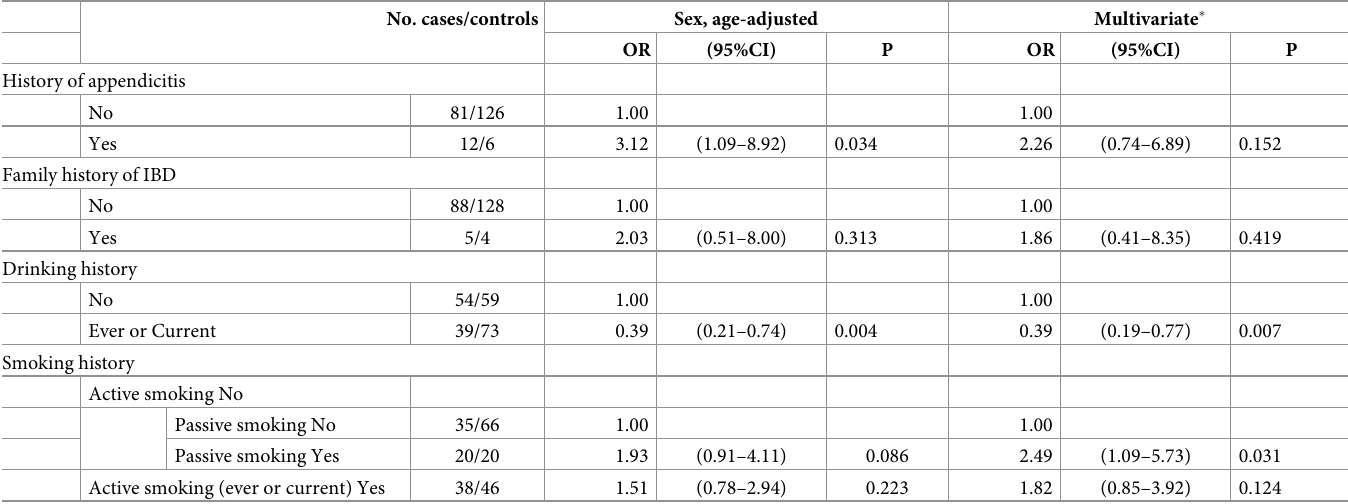
Table 3. Odds ratios of environmental factors for development of Crohn’s disease.